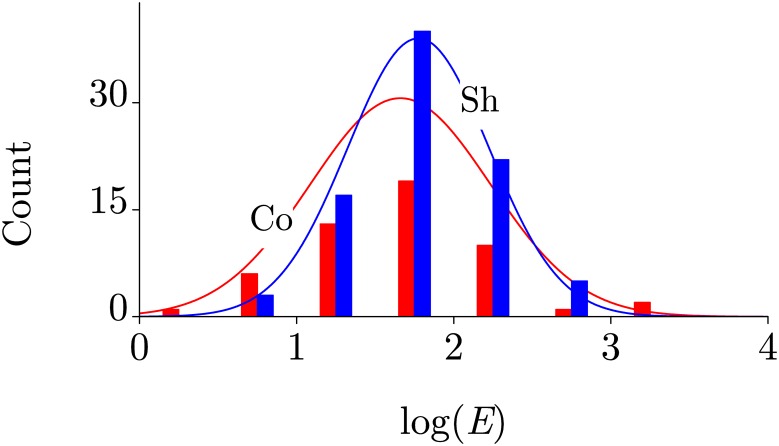
Distributions of the magnitudes of HMF effects.Distributions in groups of HMF obtained by compensating and shielding.